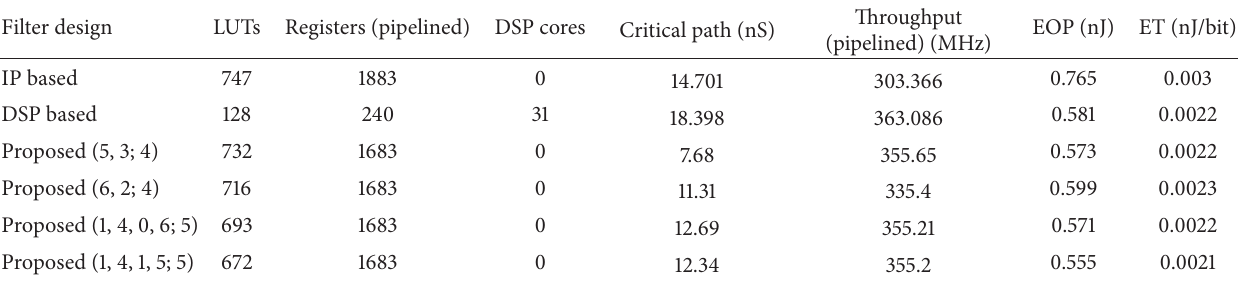
Table 3: Performance comparison for proposed GPC-based filters and DSP, IP based